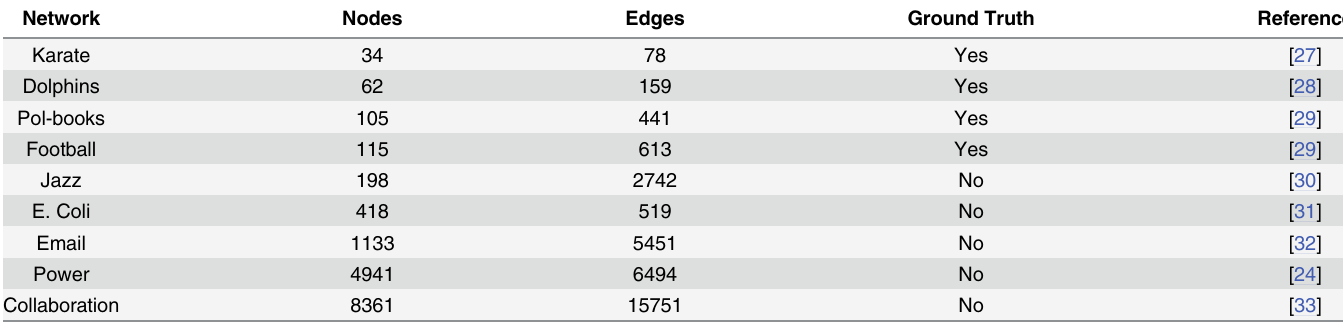
Table 4. Summary of the real-world